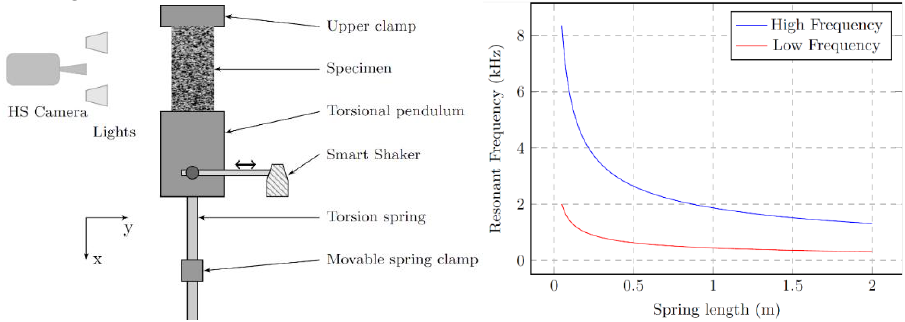
Fig. 1. Apparatus used for loading specimens Fig. 2. Range of obtainable resonant